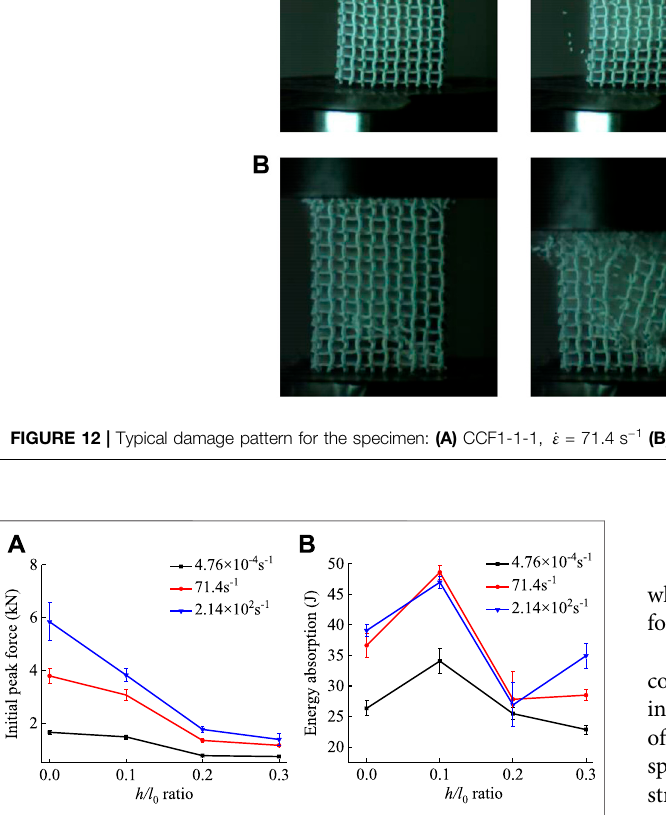
Frontiers in Materials |